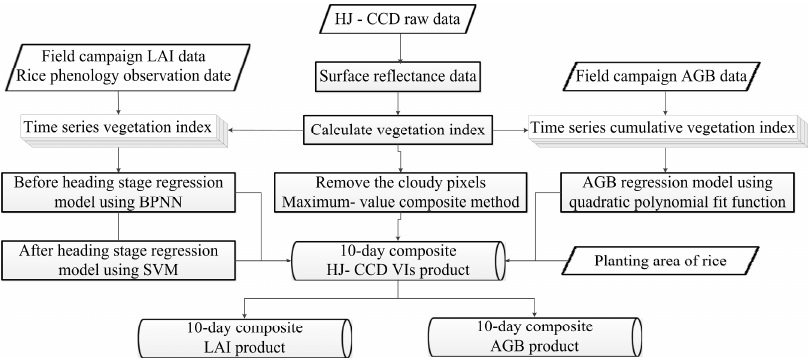
Figure 11. Flow chart of rice growth dynamic mapping.